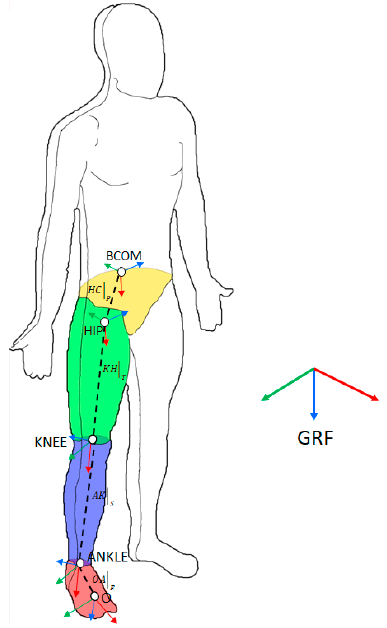
Figure 3. Inverse kinematic reconstruction scheme. BCOM—whole-body center of mass; H—hip; K—